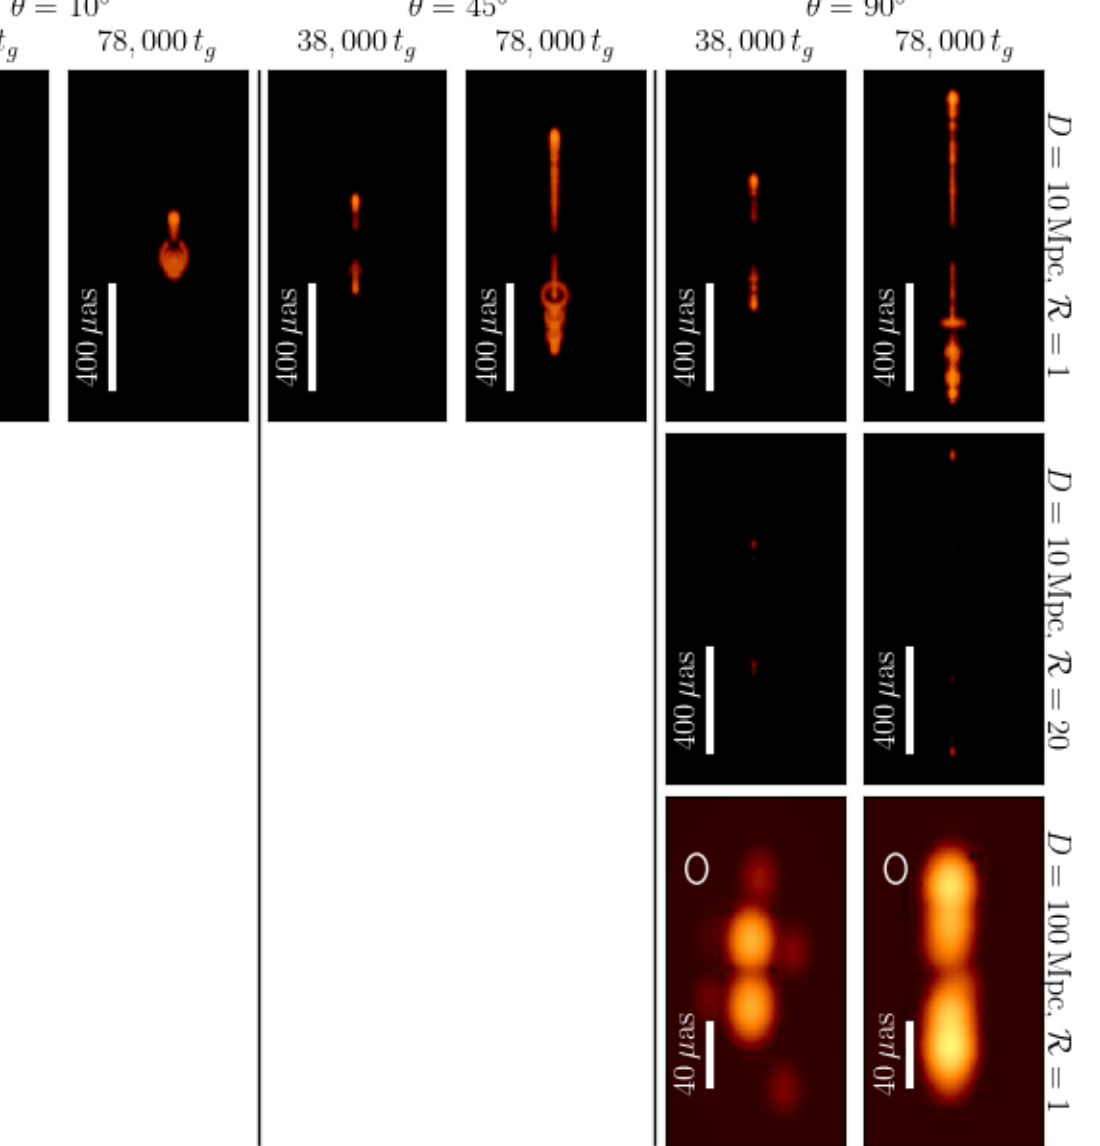
Figure A4. The same as Figure A3 but showing the reconstructed images. Note that the intensity scale for each panel is the same as the corresponding panel in Figure A3 for